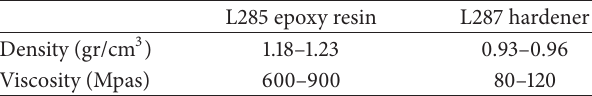
Table 1: Density and viscosity of the resin and its hardener. Table 2: Configuration of produced shaft specimens for two different production methods.